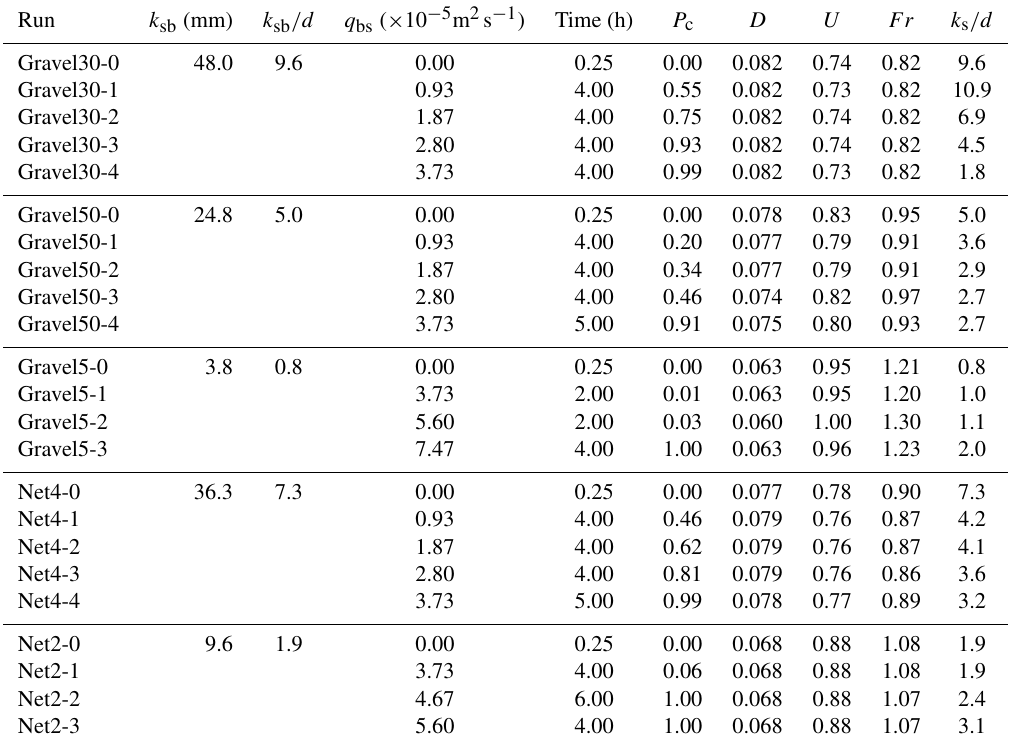
Table 1. Experimental